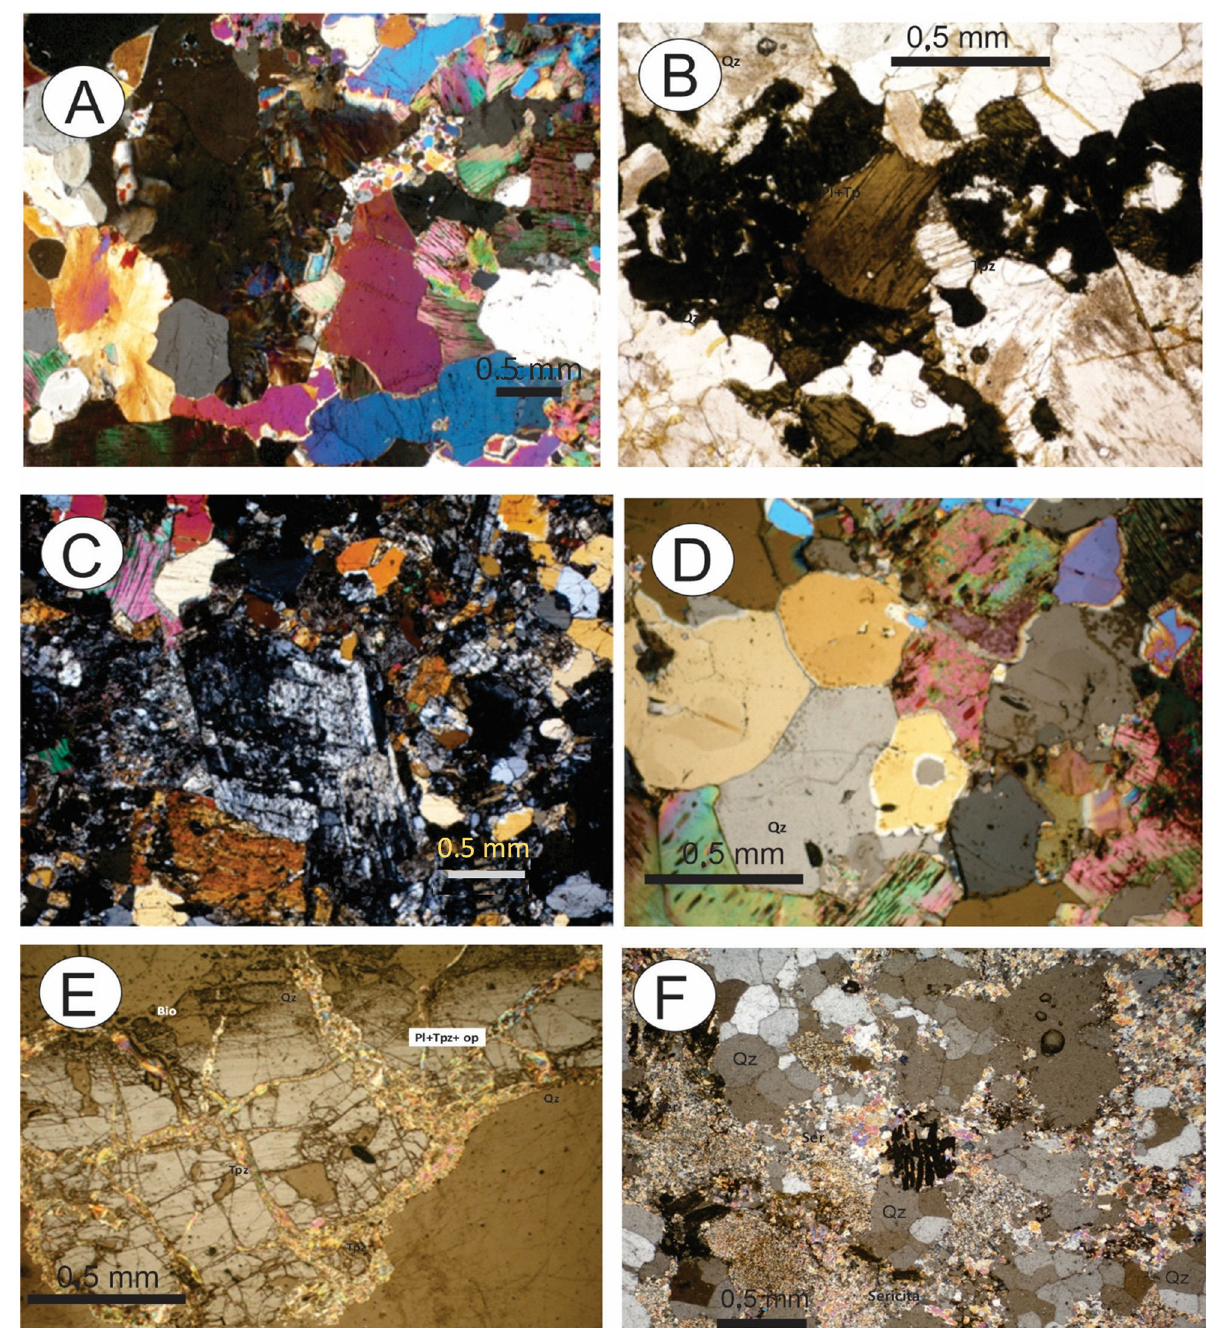
Figure 12. Macroscopic aspect of the albite-granite topaz. ( A ) Microscopic appearance of alkali-granite with feldspar with sericitic alteration in the center and with alteration crown at the edges in contact with microcline crystals. ( B ) Porphyritic gray syenogranite with feldspar veins shows microcline twin crystals in contact with anhedral quartz and biotite clusters. In ( C , D ) photomicrographs with parallel and crossed nicols showing beige to brown biotite clusters. In ( E , F ) photomicrographs with parallel and crossed nicols of well-altered biotite with inclusions of titanite and chlorite.